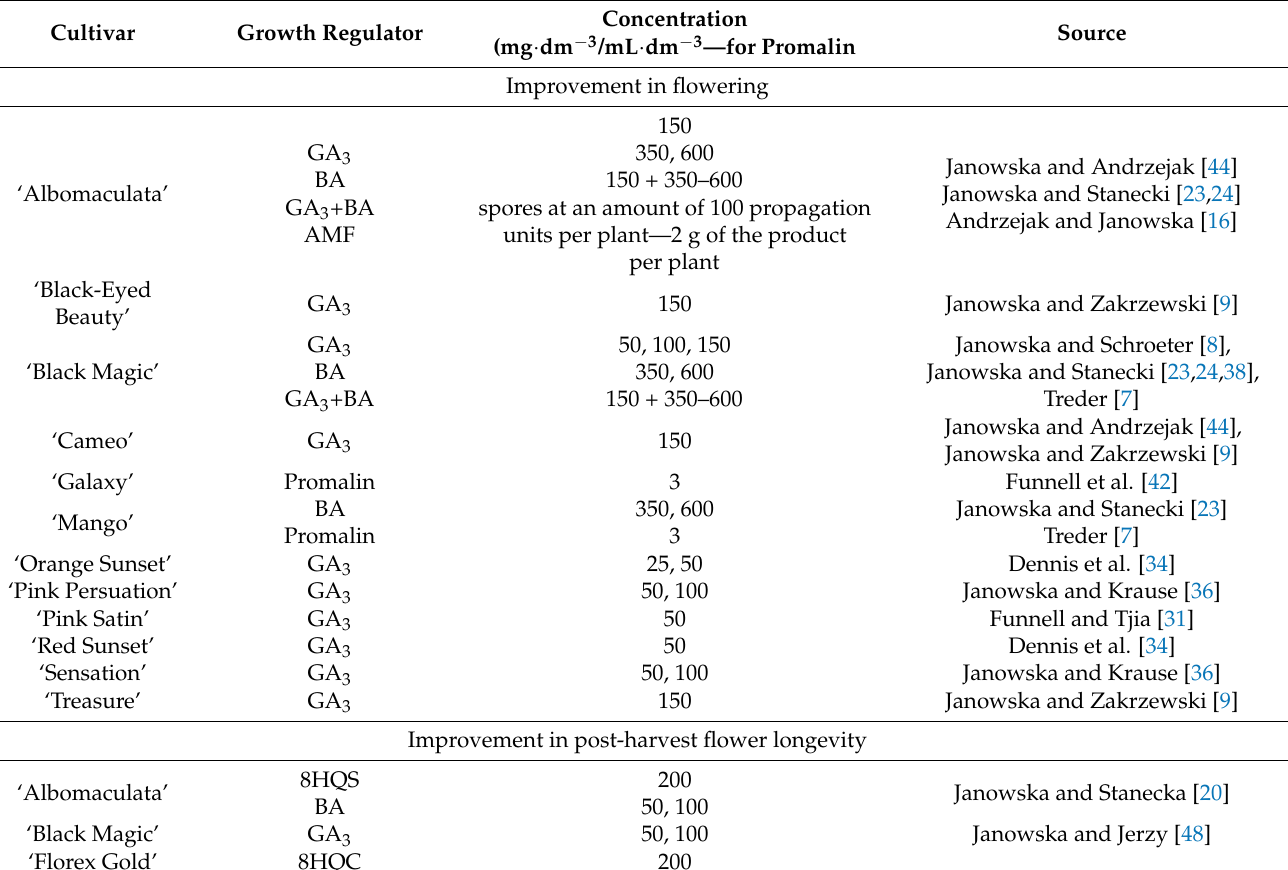
Table 2. Growth regulators and AMF used to improve flowering, change the abundance and size of stomata in the epidermis and to extend the post-harvest longevity of flowers and leaves of Zantedeschia with colourful